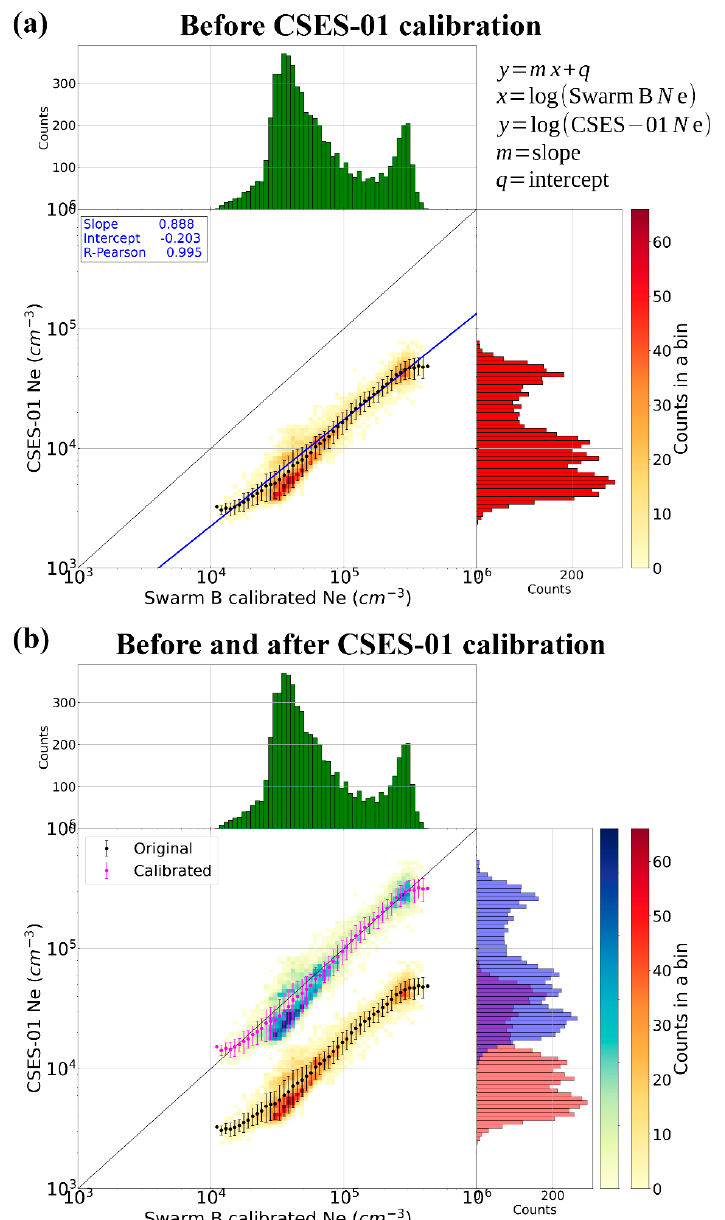
Figure 5. JPDs between CSES-01 LP N e ( y -axis) and Swarm B LP N e calibrated with FP ( x -axis) mean values represented in Figure 3 for the daytime sector (13:00 − 15:00 LT). Panel ( a ) refers to CSES-01 before the calibration, while Panel ( b ) also shows the distribution of CSES-01 after the calibration. In each panel, histograms of the counts are also reported: on the right and in red for CSES-01 LP before the calibration, in blue for CSES-01 LP after the calibration, and on the top and in green for Swarm B LP N e calibrated with FP. The black dots refer to the mean values of original CSES-01 N e conditioned by Swarm B LP N e calibrated with FP, with the corresponding standard deviation as error bar. The magenta dots refer to the mean values of calibrated CSES-01 N e conditioned by Swarm B LP N e calibrated with FP, with the corresponding standard deviation as error bar. The blue line in Panel ( a ) is the linear fit performed on black dots, with corresponding coefficients given in the legend. The thin black line is the first-third quadrant bisector.